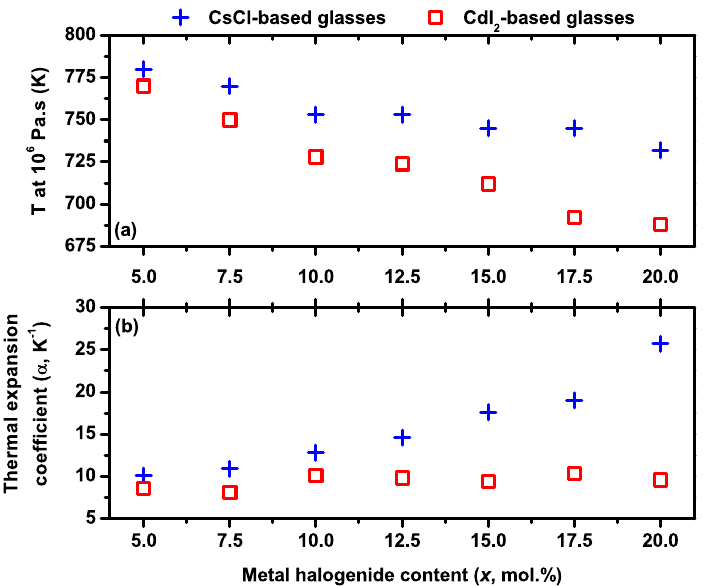
Figure 2. ( a ) Evolution of the measured temperature at a viscosity of 10 6 Pa · s as a function the metal halide CsCl (blue crosses) or CdI 2 (red squares) content. ( b ) Evolution of the thermal expansion coefficient as a function the metal halide CsCl (blue crosses) or CdI 2 (red squares) content.